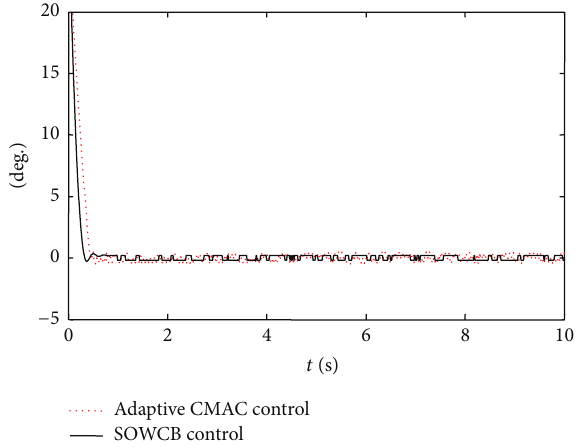
Figure 11: System step response tracking